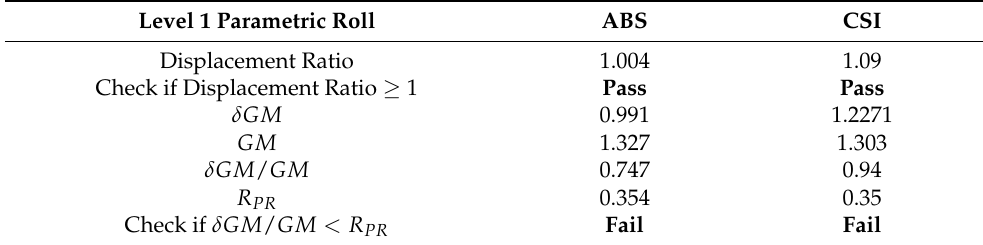
Table 32. Level 1 assessment of parametric roll failure mode for KCS container ship.